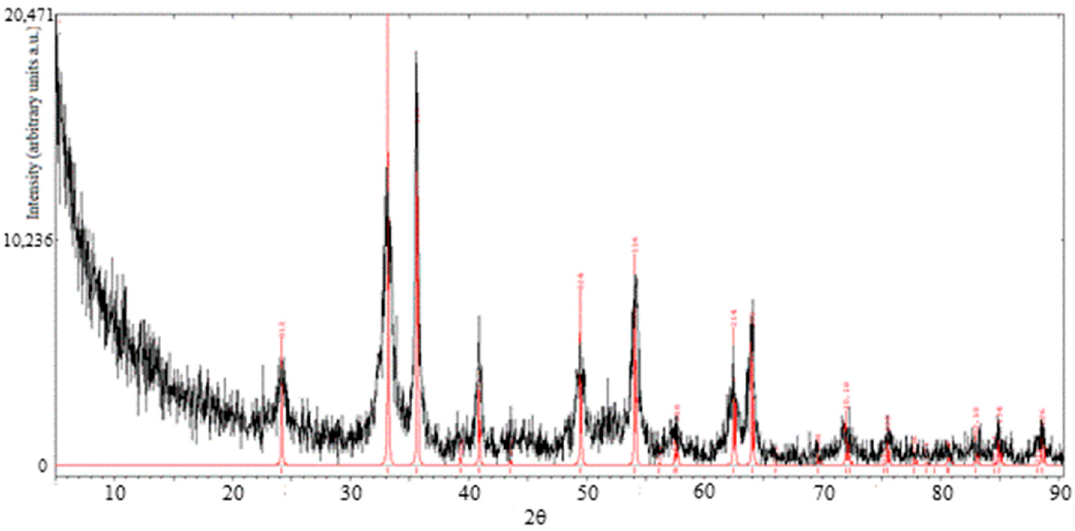
Figure 5. XRD patterns of hematite sample (black curve) and reference hematite (red curve).